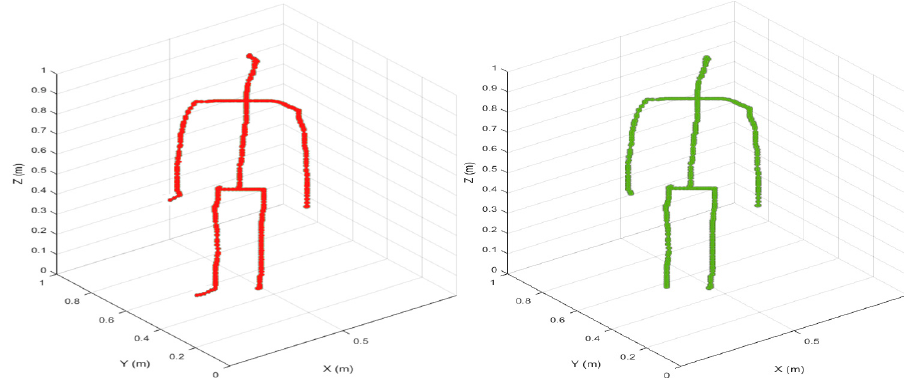
Figure 14. Pose estimation of standing position.